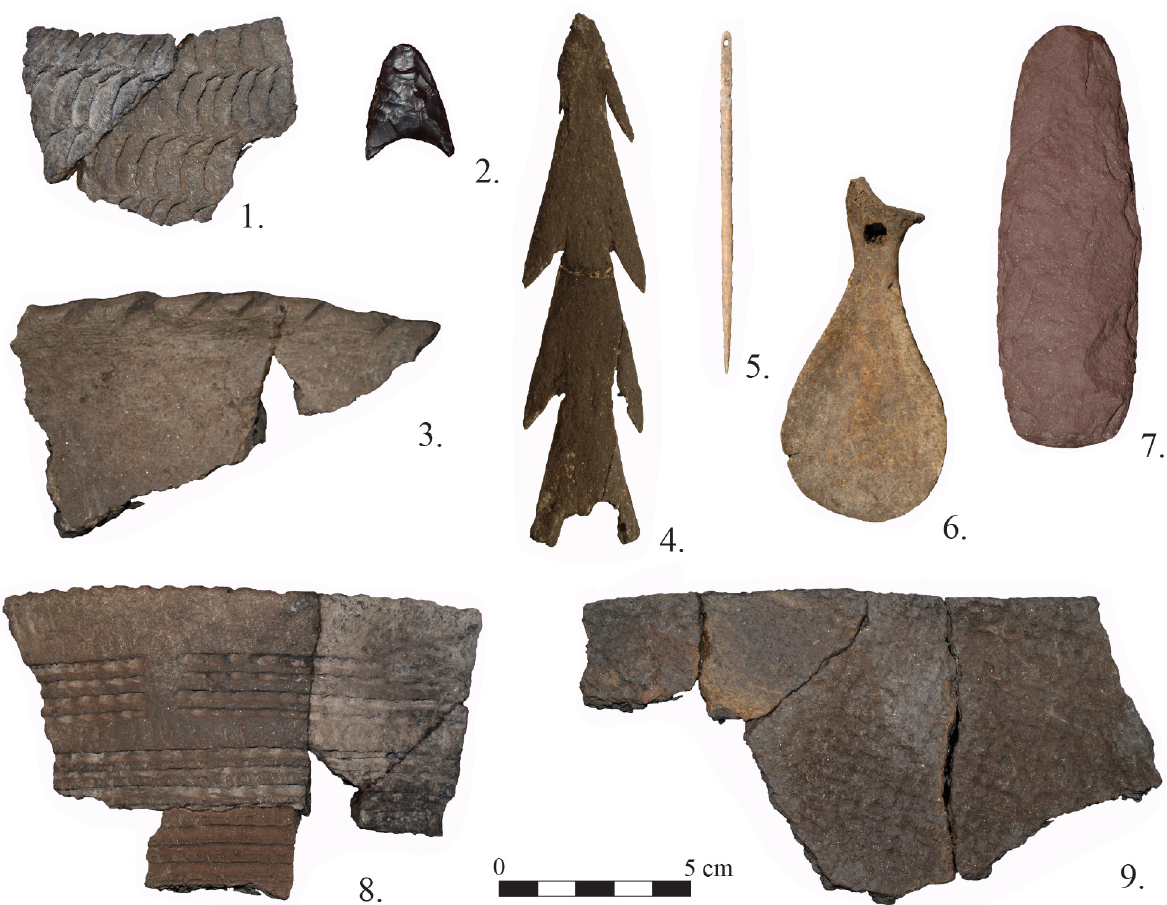
Fig 8. Examples of artifacts found at Sagan-Zaba II. Numbers 1 and 3 are from Late Holocene layers IIIB-I; 2, 5, and 7 are from Middle Holocene layers V-IV; 4 and 9 are from Early to Middle Holocene layers VII-VI (photographs by T. Nomokonova).